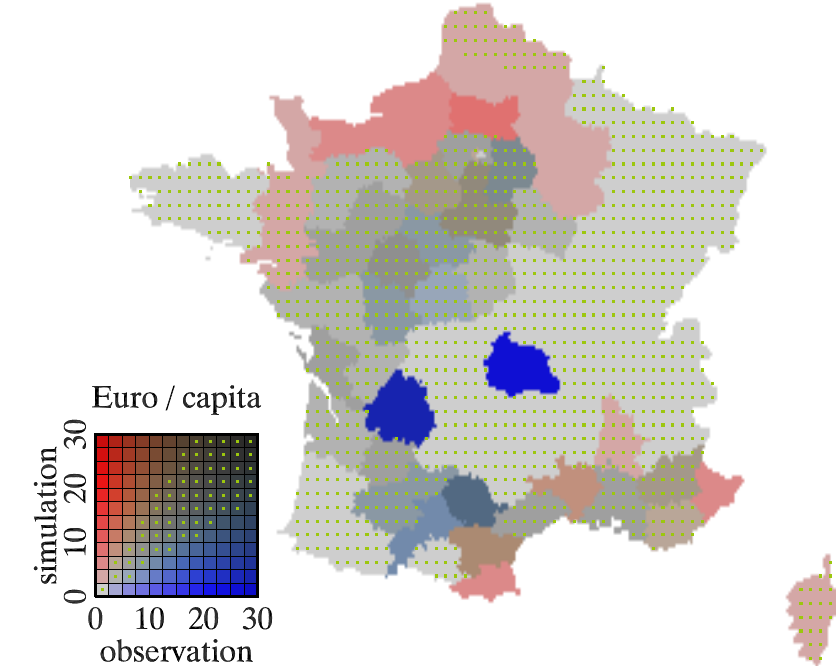
Fig. 4. Damage time series for simulations and observations of drought-induced soil subsidence with uncertainty range.